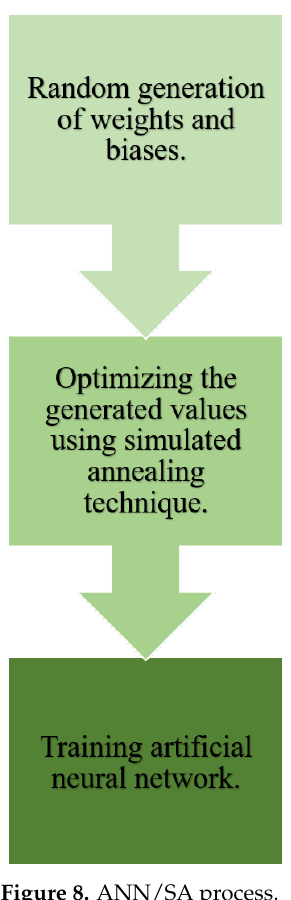
Figure 8. ANN/SA